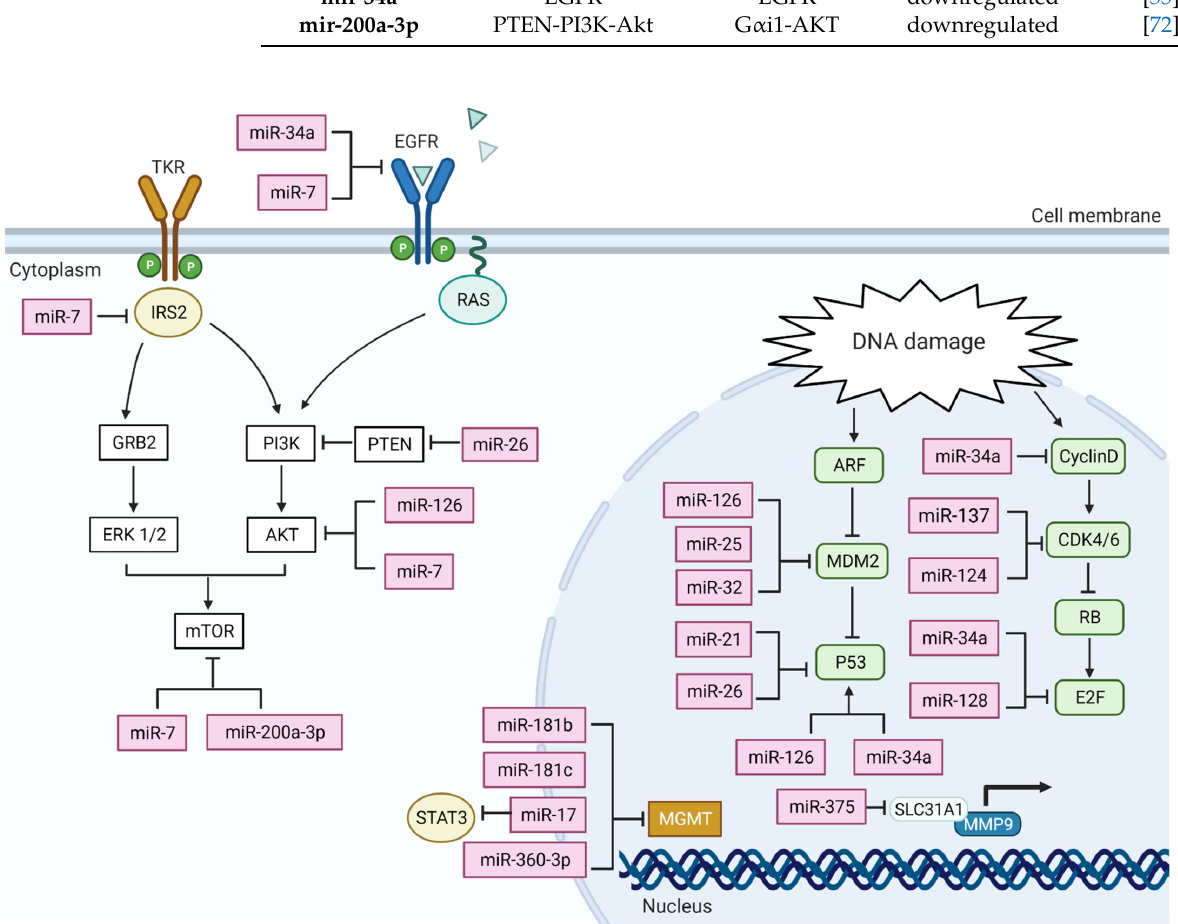
Figure 1. A diagram of miRNAs associated with major altered pathways reported in GBM development, including the P53 pathway, RB pathway, and P13K pathway. The function and the interaction of these miRNAs are based on their mechanistic studies following their baseline expression in GBM cells and tissue. An arrow ( → ) out of any miRNA represents a direct activation towards a targeted gene. For example, in the nucleus, it is reported that miR-126 targets P53, and an increase in miR-128 expression leads to an increase in the expression level of P53. Conversely, the symbol ( ⊢ ) represents an inhibition by miRNA towards a targeted gene. For example, an up-regulated expression of miR-34a leads to an inhibition in the expression of cyclin D gene. Figure created with